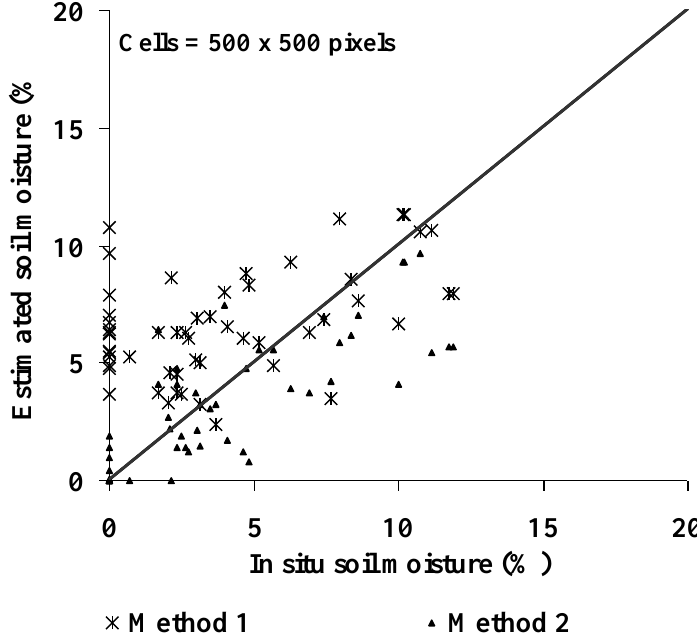
Figure 11. Comparison between estimated and in situ soil moisture contents. The overestimate of soil moisture on plateaus (very low mv ) is due to a stronger soil roughness (cuirass).